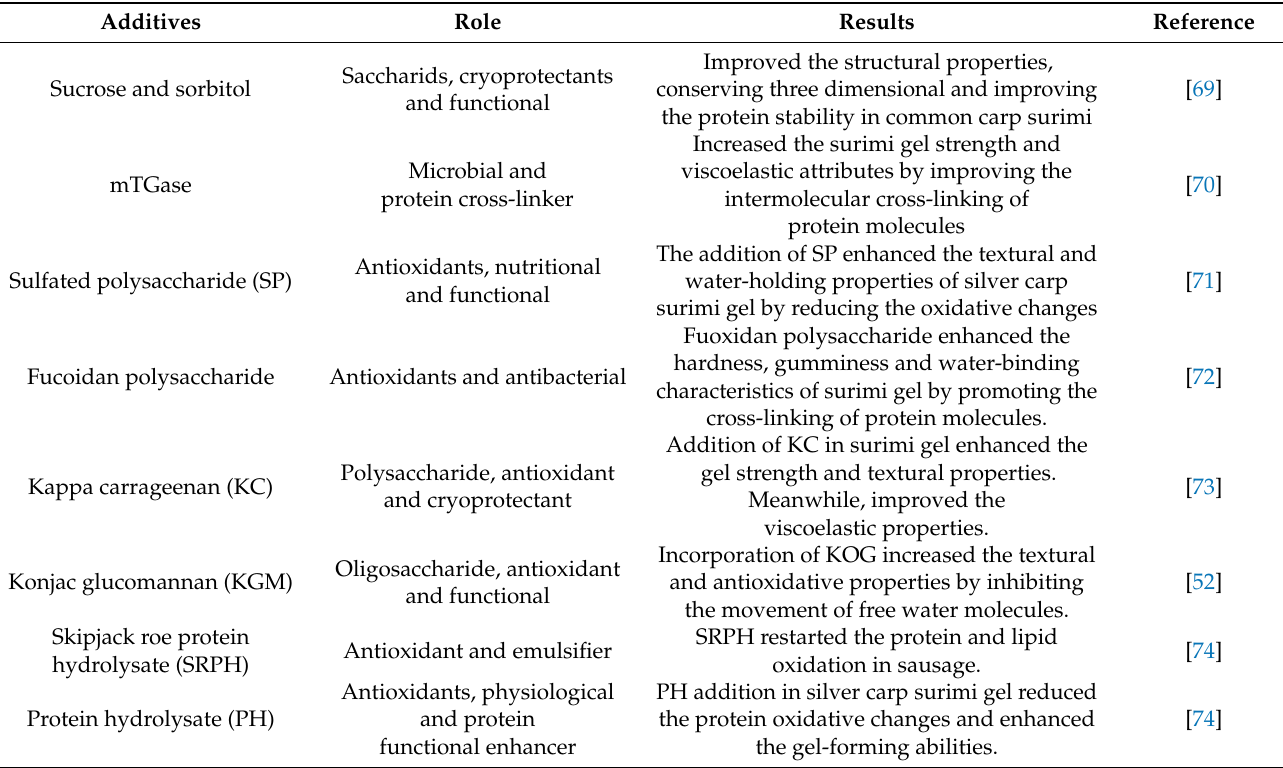
Table 1. Role of different additives in the enhanced surimi gel